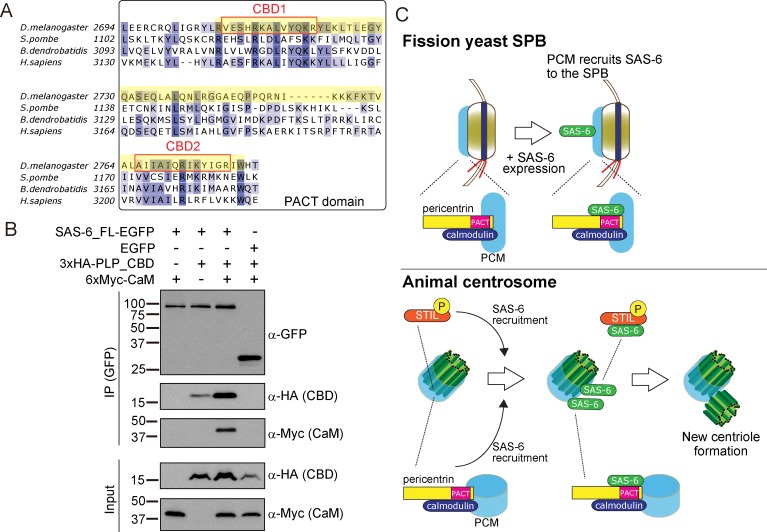
SAS-6 interacts with the calmodulin binding domain within PACT.(A) Graphical representations of the calmodulin (CaM)-binding domains (CBD1 and CBD2) within the multiple sequence alignment of the PACT domain of pericentrin proteins in the indicated species. CBD1 and CBD2 are marked with red squares. In yellow, minimal fragment containing both CBD1 and CBD2 (hereafter called CBD and used for subsequent experiments). The sequences of the PACT domain were aligned using Clustal Omega multiple sequence alignment tool and visually represented using Jalview software (McWilliam et al., 2013; Waterhouse et al., 2009). The alignments are color-coded in shades of blue for the percentage identity of amino acids; darkest blue (>80%), mid blue (>60%), light blue (>40%), white (<=40%). (B) Complex formation between SAS-6, the highly conserved CBD within PACT domain and calmodulin. Protein extract was prepared from the D.Mel cells expressing SAS6-EGFP or EGFP, HA-tagged CBD and Myc-tagged calmodulin. The GFP-tagged proteins were immunoprecipitated with anti-GFP antibody. Immunoprecipitates and inputs (20%) were analyzed by western blotting using the indicated antibodies. (C) Schematic representation of the ancestral role of the PCM in recruiting centriole proteins, centriole biogenesis and elongation. When SAS-6 was heterologously expressed in fission yeast cells, it localized to the SPB through interaction with Pcp1/pericentrin (upper panel). This revealed a novel interaction between SAS-6 and pericentrin in animals, which is important for centriole biogenesis (lower panel). It is likely that SAS-6 is recruited to the pre-existing centriole prior to new centriole formation by two complementary pathways: PLK4-STIL/Ana2 and pericentrin. Eventhough yeast and animals are separated by one billion years of evolution, the pericentrin/Pcp1-SAS-6 interaction surface has been conserved, likely because the binding of pericentrin to calmodulin constrained its evolution.